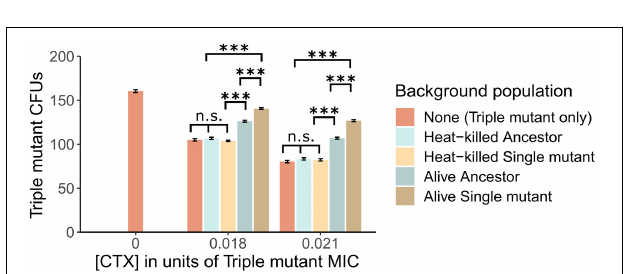
FIGURE 2 | The establishment of Triple mutant cells is shown as counts of CFUs under the exposure of two CTX concentrations (shown as a fraction of the Triple mutant’s MIC), in the absence and presence of a “Background population”: 10 6 alive or heat-killed Ancestor cells, and alive or heat-killed Single mutant cells. In addition, the number of Triple mutant CFUs is shown in the absence of CTX. Significance levels based on Tukey’s HSD tests are shown within CTX concentrations, between the type of Background population after running two-way ANOVA’s over the whole dataset (cf. Supplementary Table 2 ). n.s., not significant, ∗∗∗ p <